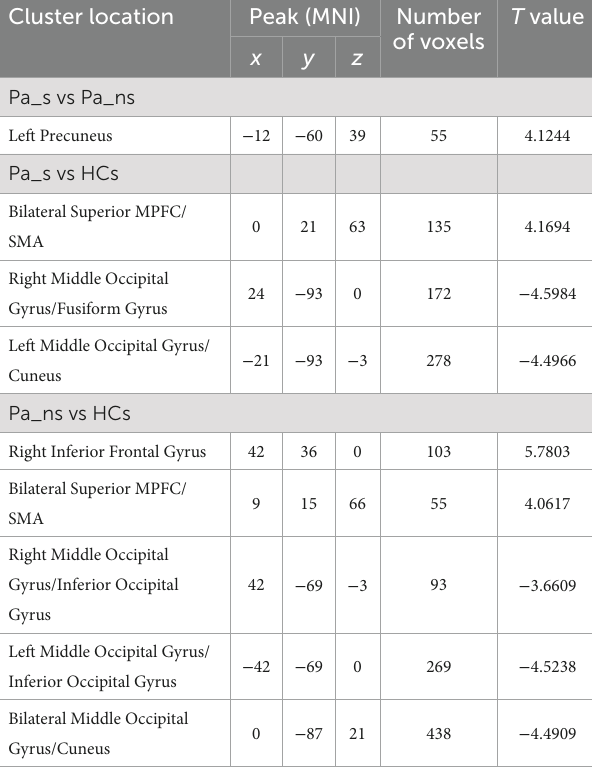
TABLE 2 Significant fALFF differences across three groups. Cluster